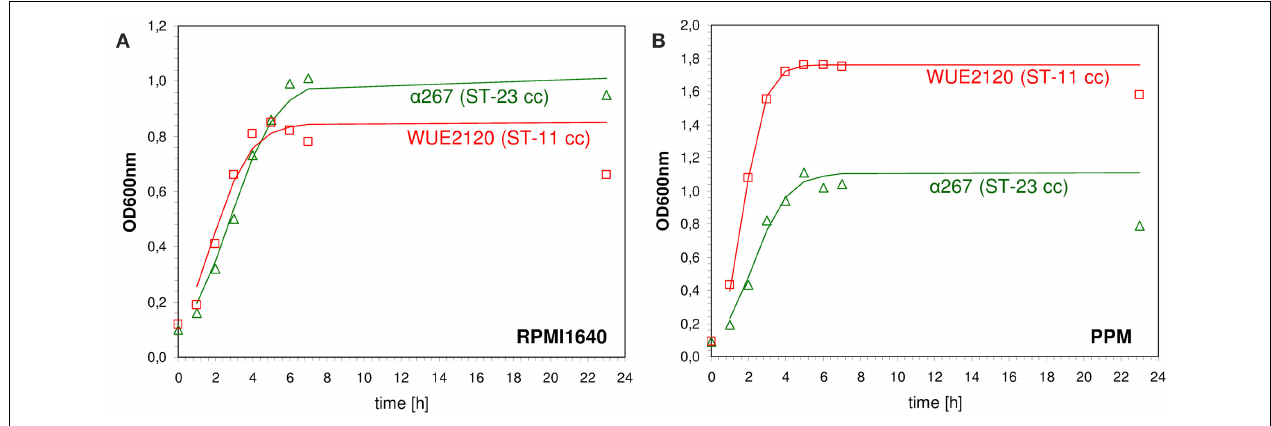
FIGURE 3 | Measured and fitted growth kinetics for two different meningococcal strains. The cultures were incubated at 37.0 ◦ C at 200rpm either in defined medium (RPMI 1640, Biochrom AG, Germany) (A) or in rich medium [proteose peptone medium supplemented with 1% Polyvitex (Biomereux) (PPM + )] (B) . The optical density at 600nm ( OD 600 nm ) was determined at eight different time points over a period of 24h starting with